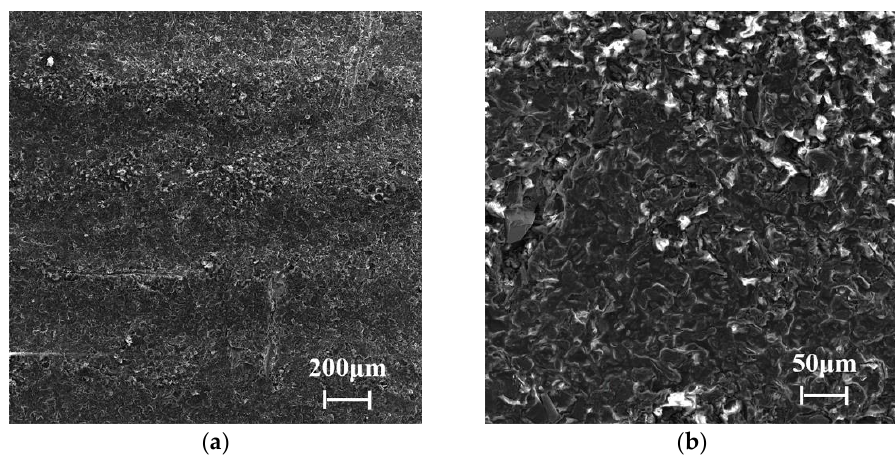
Figure 6. Morphologies of the skirt surface at different magnifications: ( a ) 200 ×